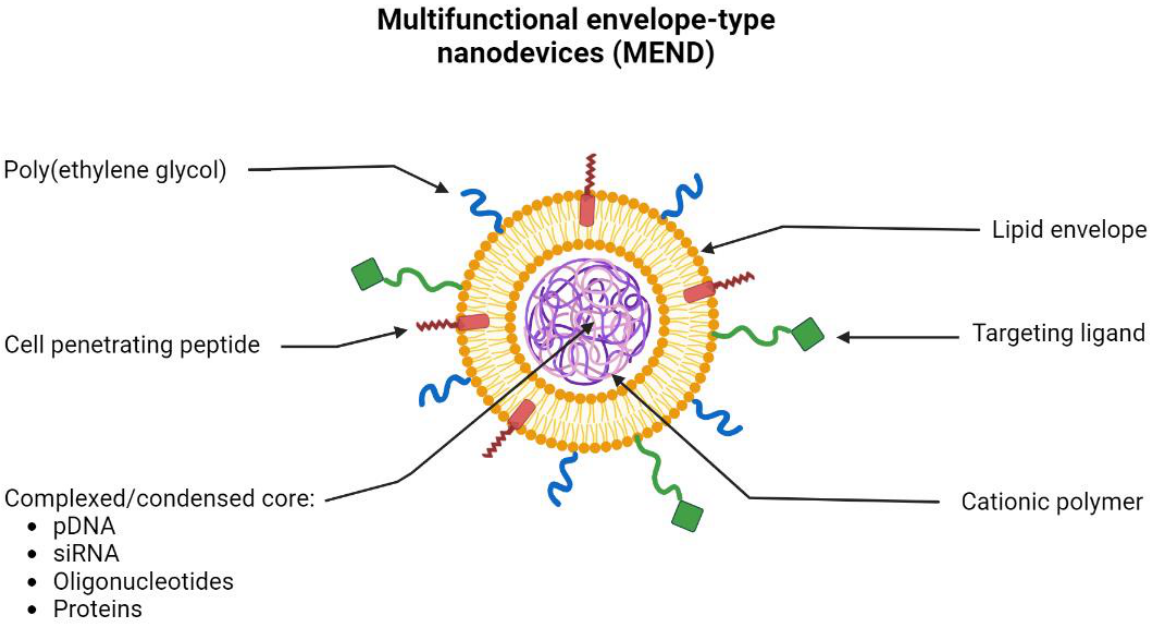
Figure 6. Schematic representation of the morphology and constitution of the multifunctional envelope-type nanodevice (MEND). MEND consists of a lipid envelope that is modified with cell-penetrating peptides (CPP), poly(ethylene glycol) (PEG), and ligands that provide specific targeting. Inside, MEND can encapsulate/condense various therapeutic materials such as DNA, RNA, proteins, etc.